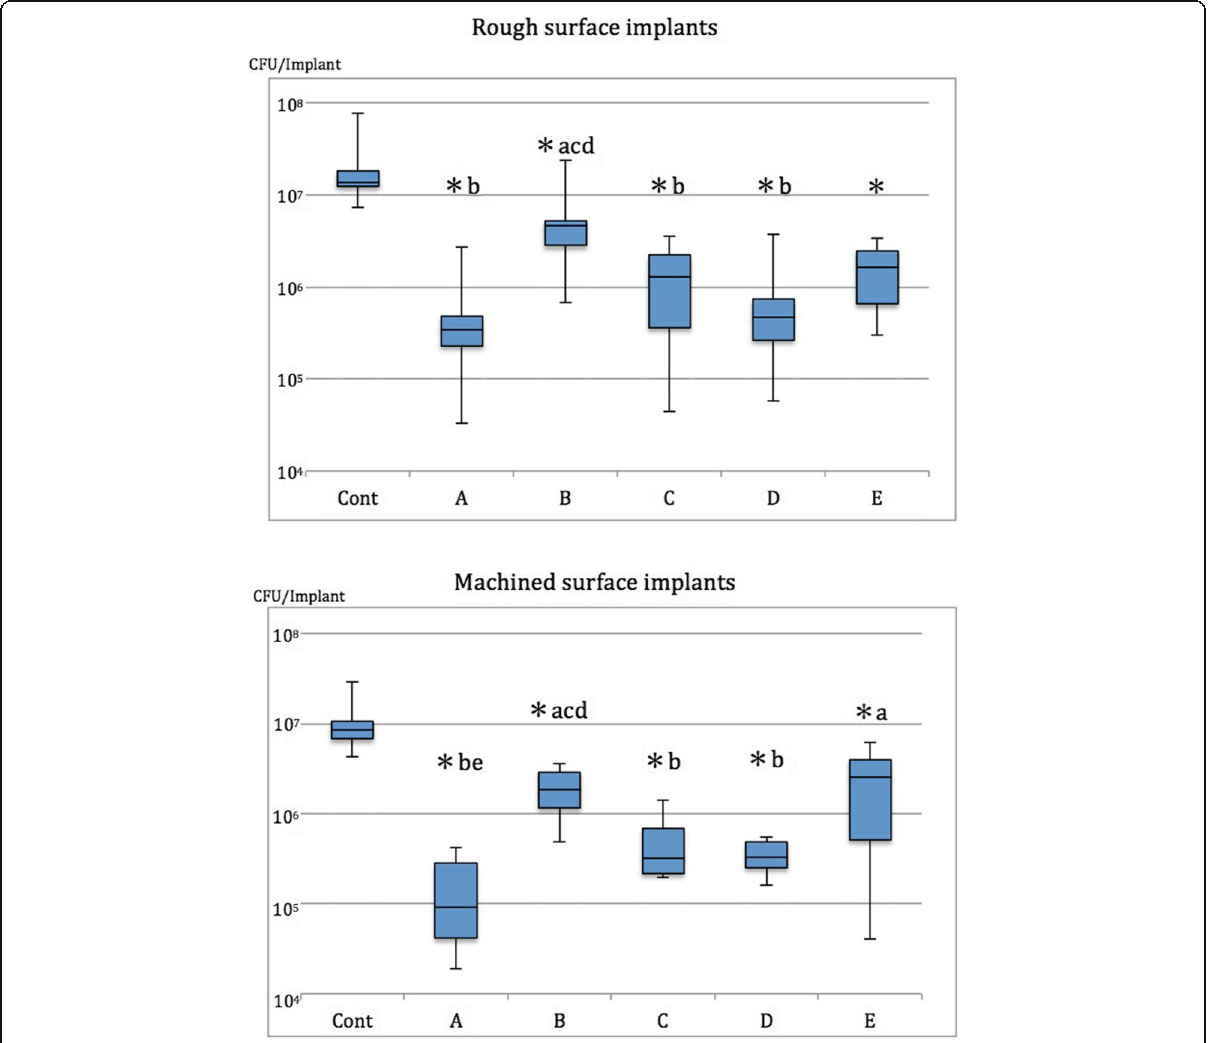
Fig. 5 Quantitative analysis of CFU counts on rough and machined surface implants after cleansing by each method. Asterisk represents vs Cont; a , vs G; b , vs US; c , vs Air; d , vs Rot; e , vs Las which indicates p <